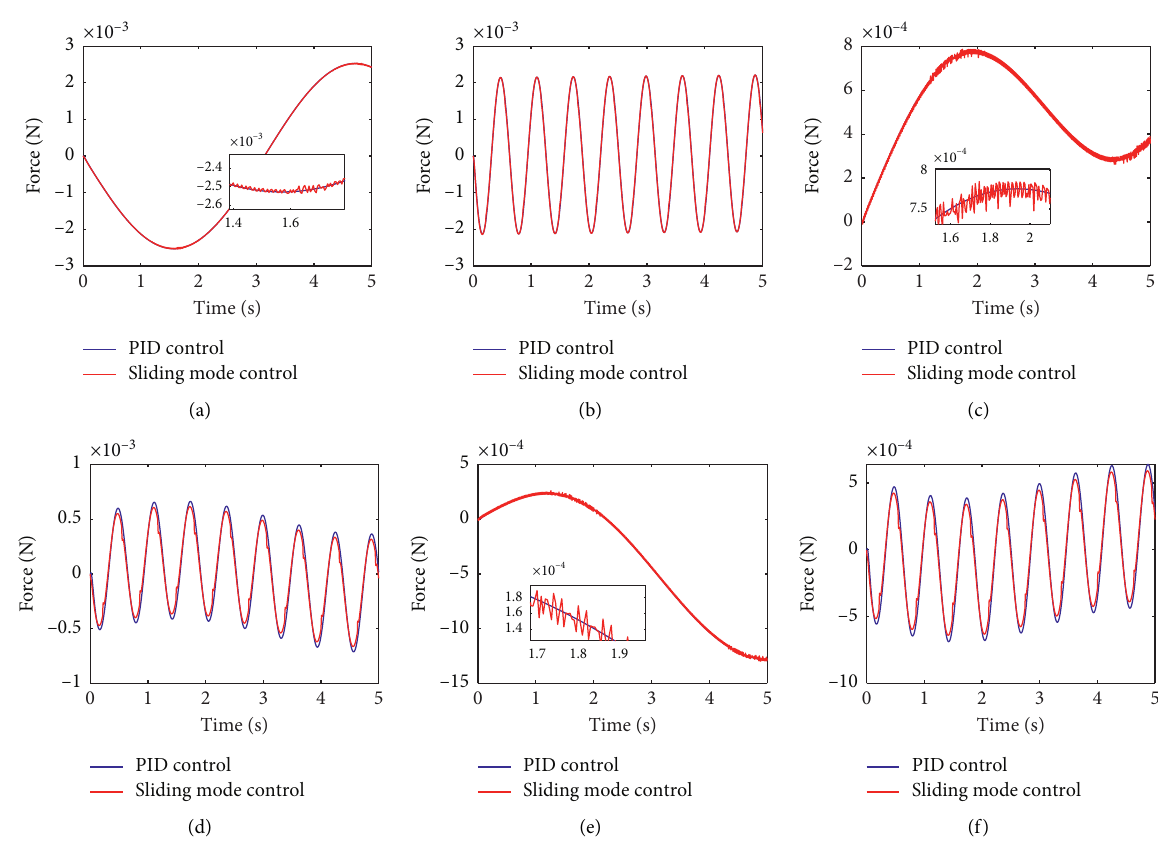
Figure 11: Comparison of PID control and slip mode control force input: (a) F